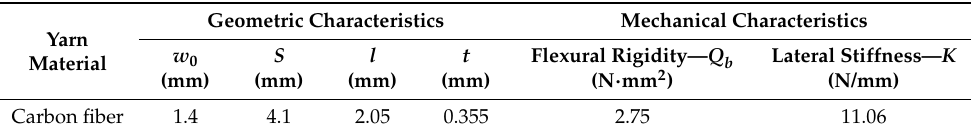
Table 1. Summary of the measured geometric and mechanical characteristics of the PWCP.